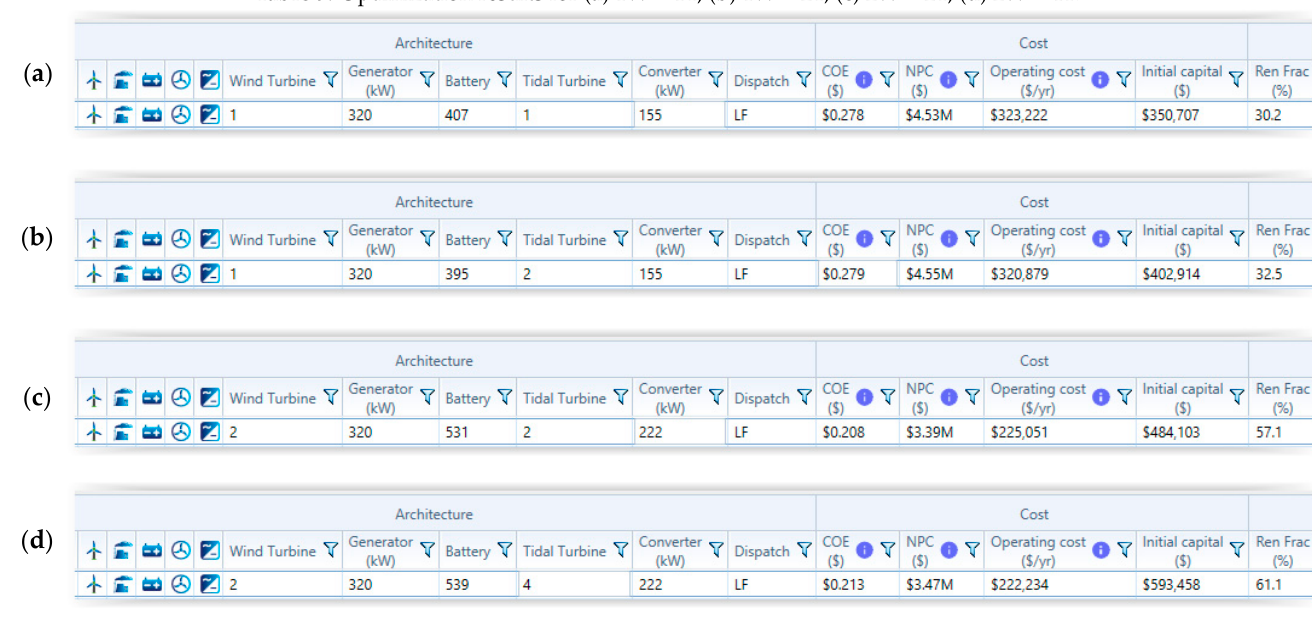
Table 10. Optimization results for balanced alternative scenario 1W + 10T.